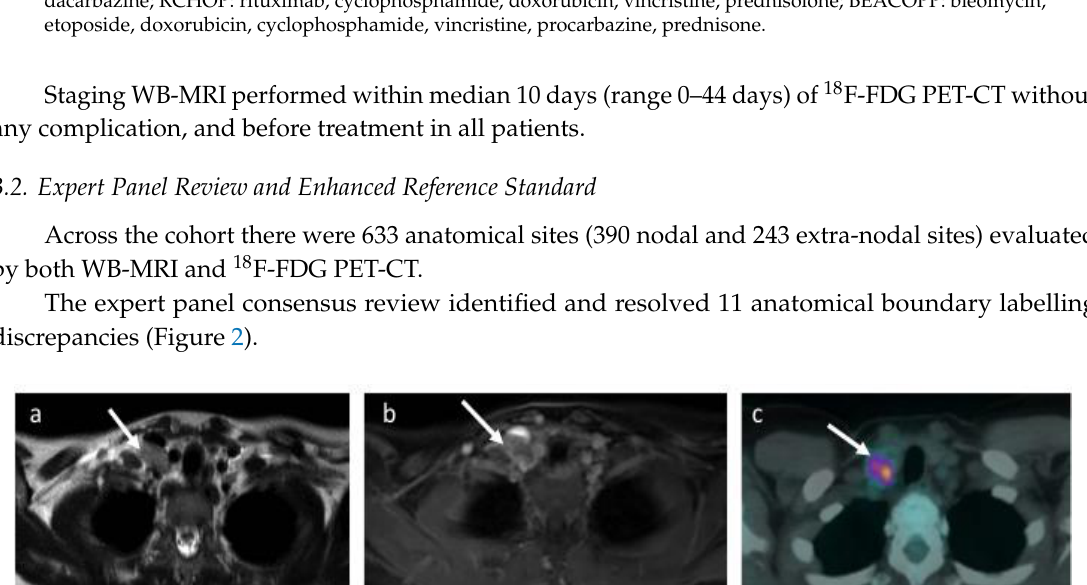
Table 2. Patients’